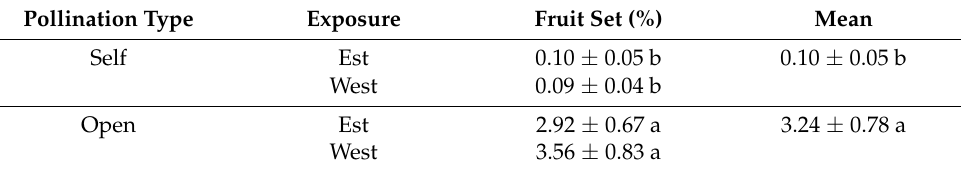
Table 5. Fruit set (%) of cv. Lecciana at veraison as effect of pollination type (Self/Open) and exposure (Est/West). Mean values of two subsequent seasons ( ± SE ). Lower case letters denote statistical differences at p = 0.05 (Siegel-Tukey